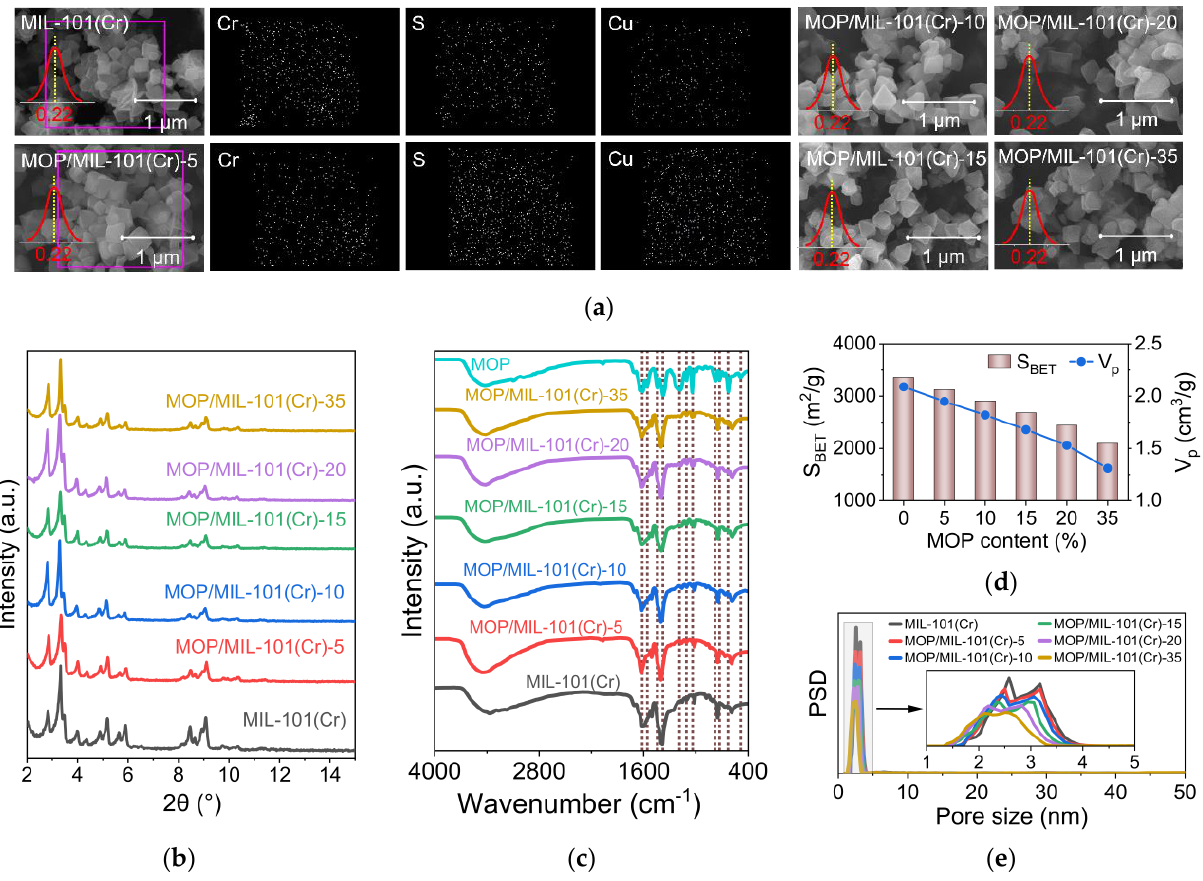
Figure 3. Structural characterization of MOP/MIL-101(Cr) composites. ( a ) SEM images, ( b ) PXRD patterns, ( c ) FT-IR spectra, ( d ) BET surface areas (S BET ) and total pore volumes (V p ), ( e ) Pore size distributions (PSD).